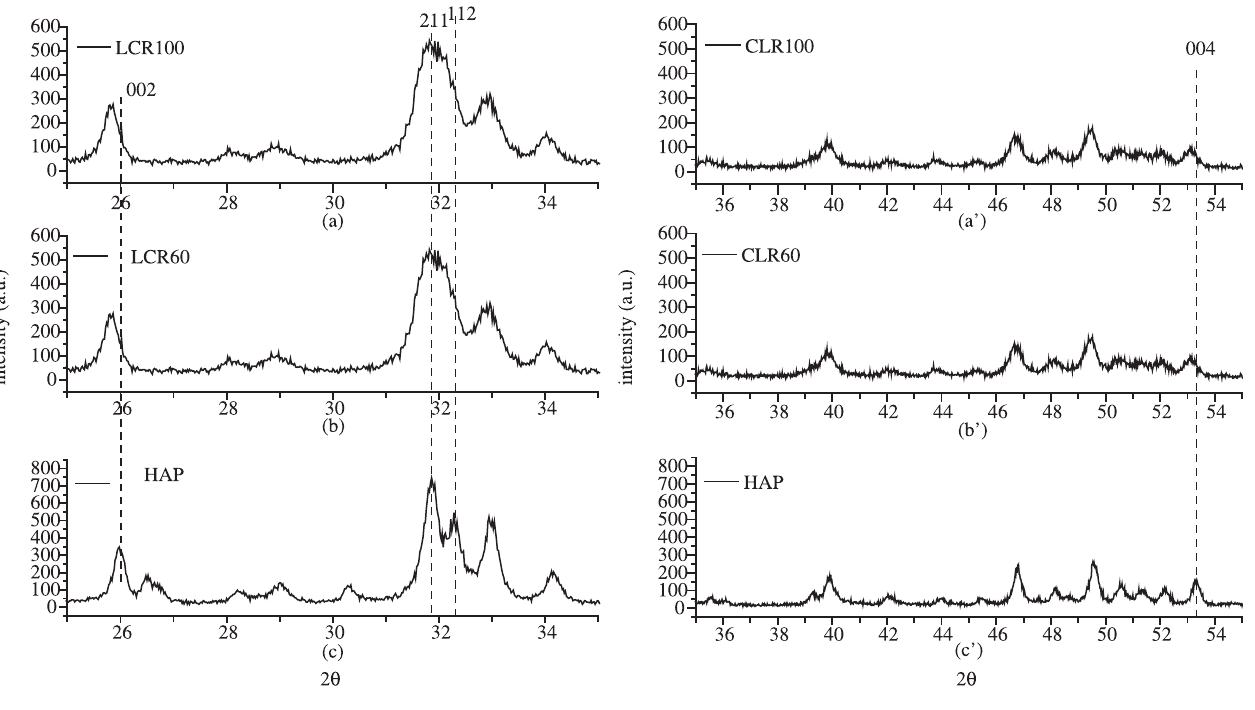
Figure 4. X-ray diffractograms for the rod-like particles synthesized in liquid crystal phases formed from a) Renex-100 TM , b) Renex-60 TM and c) for com- mercial